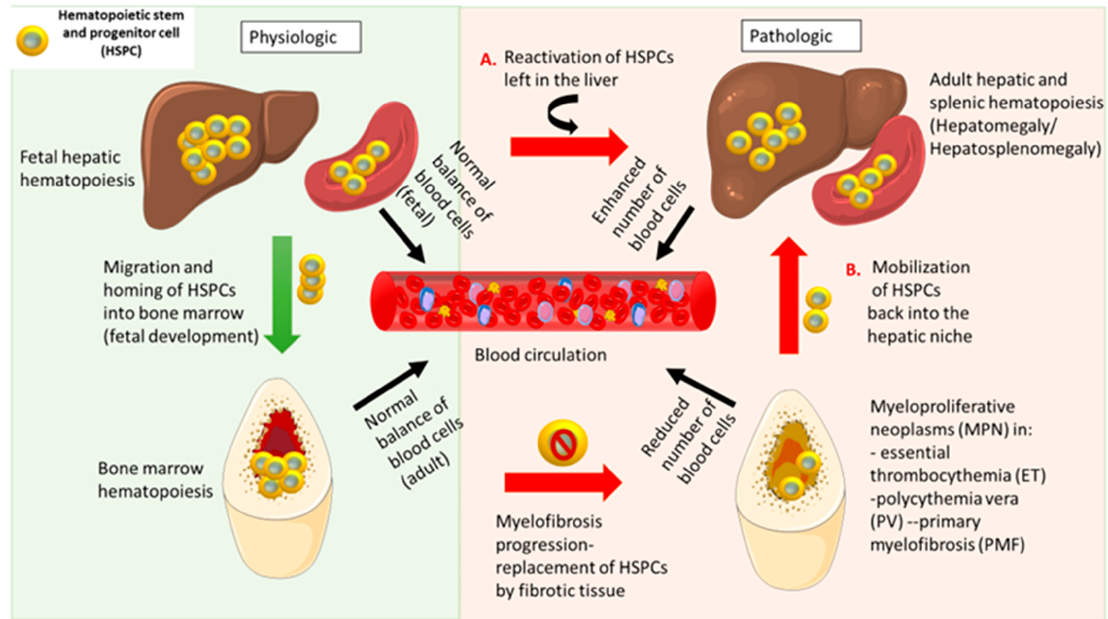
Figure 1. Physiological versus pathological hematopoiesis.